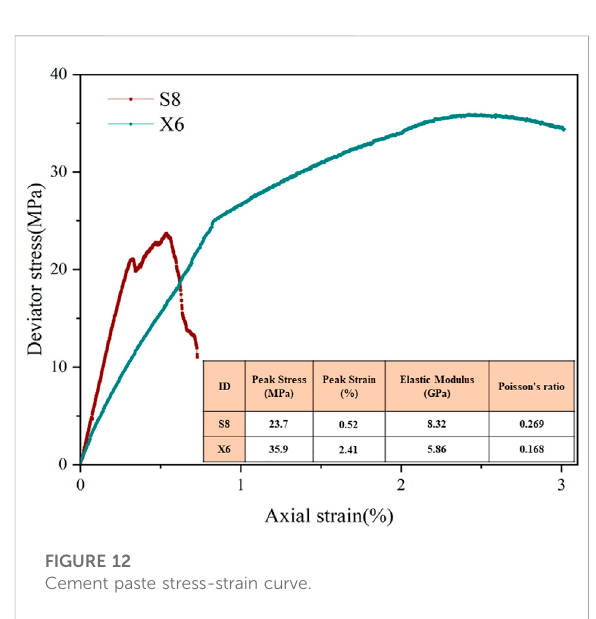
FIGURE 12 Cement paste stress-strain curve.